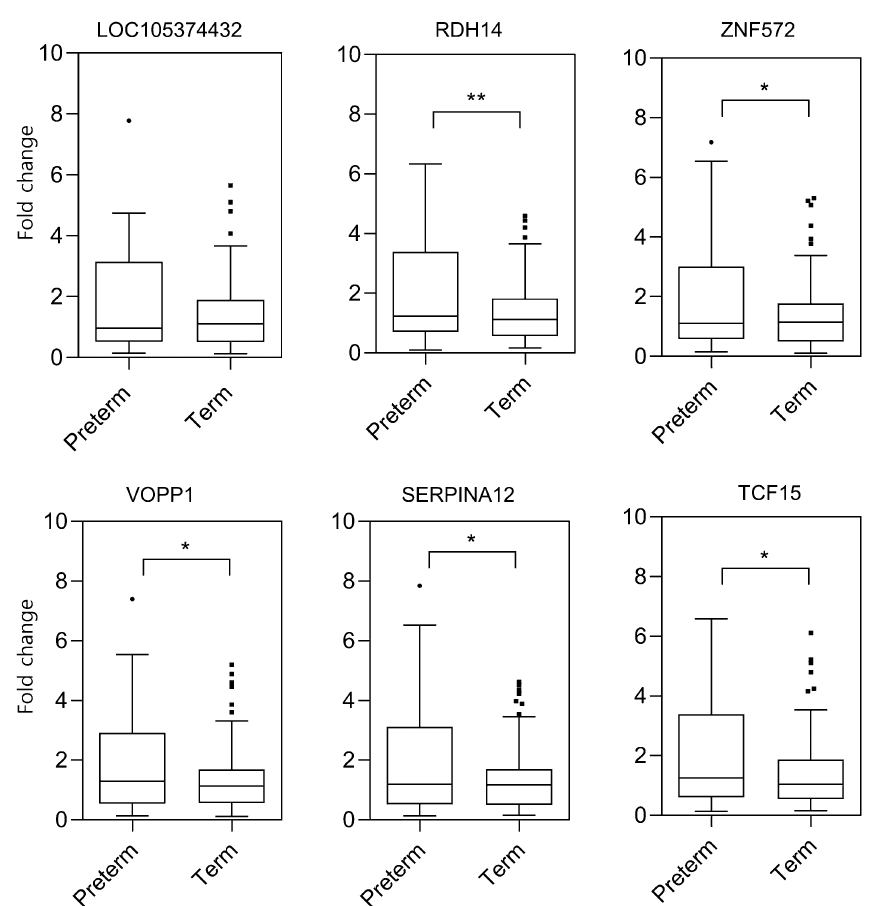
Figure 4. qRT-PCR validation of the expression of 6 chosen differentially expressed genes in the extended samples. Asterisks indicate levels of significance of differential expression (* P ≤ 0.05, ** P ≤